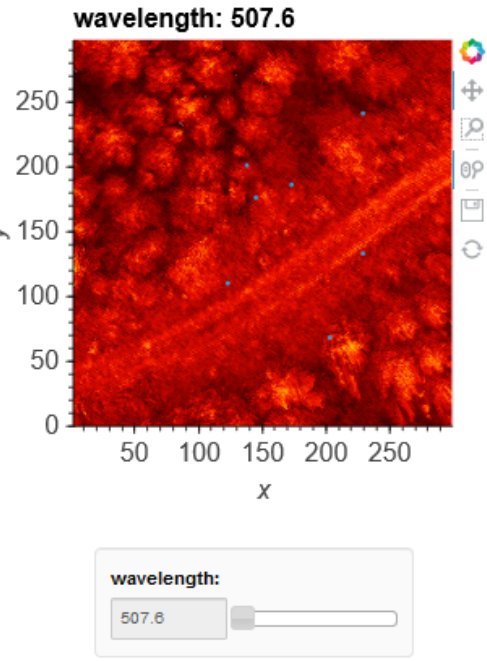
Figure 14. Screenshot of the point